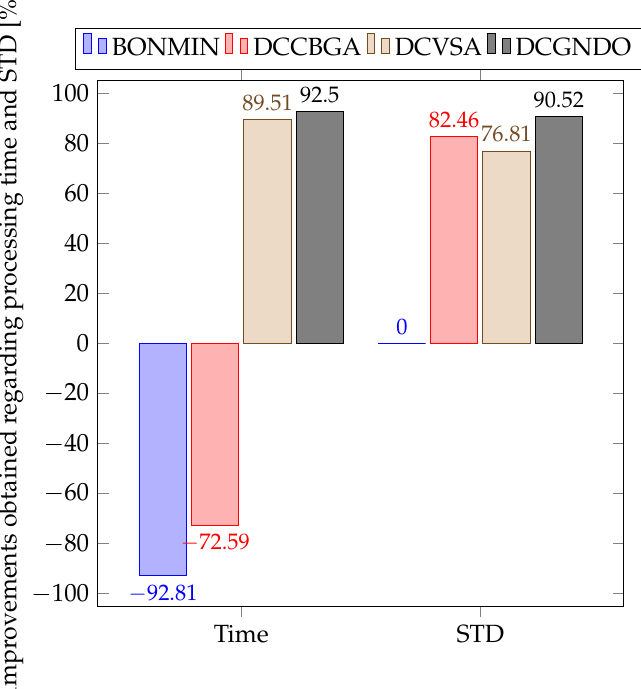
Figure 7. Improvements obtained by the DCPPSO with respect to the comparison methods in the 69-bus test system in terms of processing time and standard